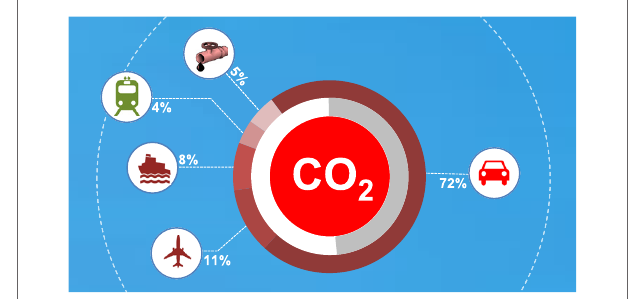
FiGUre 1 | carbon footprints of transportation and transit systems (after international Union of railway, 2016)